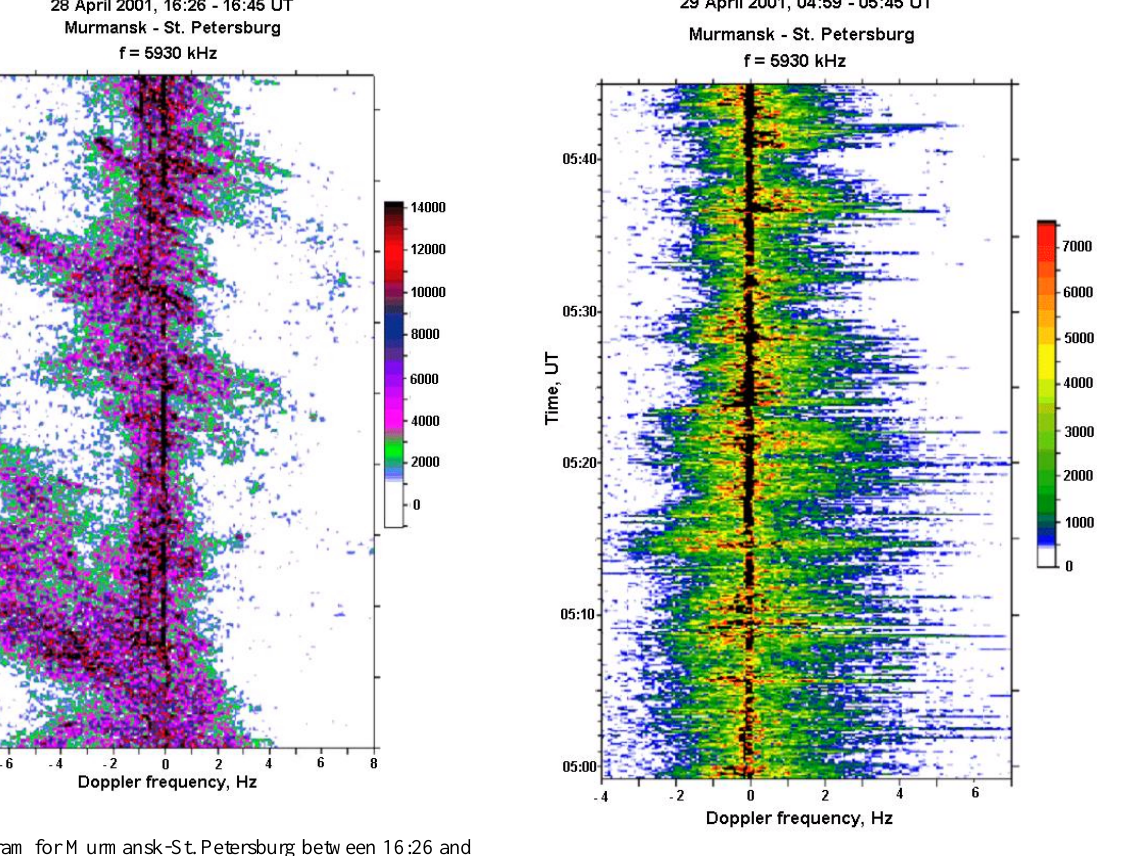
Fig. 8. Sonogram for Murmansk-St. Petersburg between 05 :00 and 05:46 UT on 29 April 2001. Numbers on the colour scale are power spectrum values, arbitrary